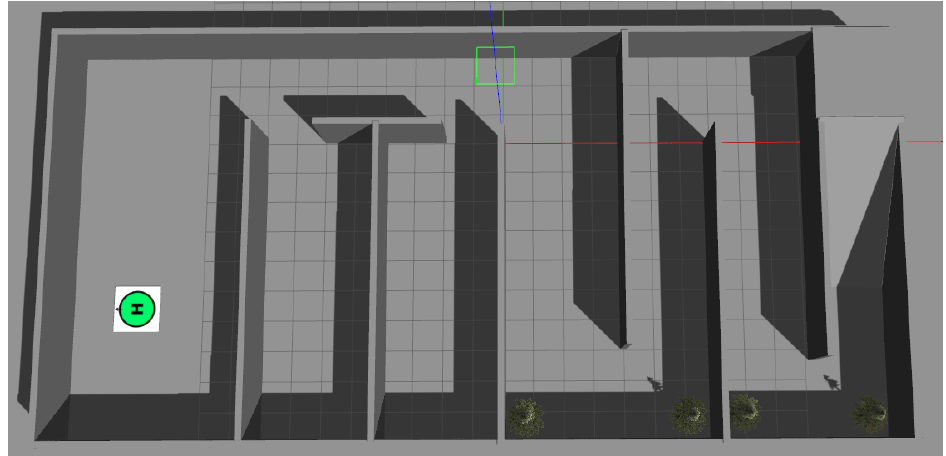
Figure 27. Unknown environment (top view of first floor). The green H is the starting location, similar to the previous environments.